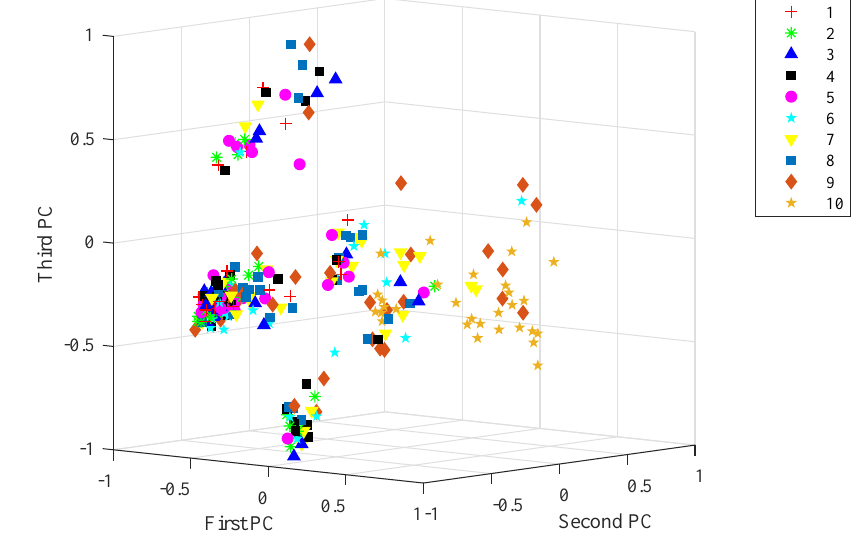
Figure 6. Raw vibration